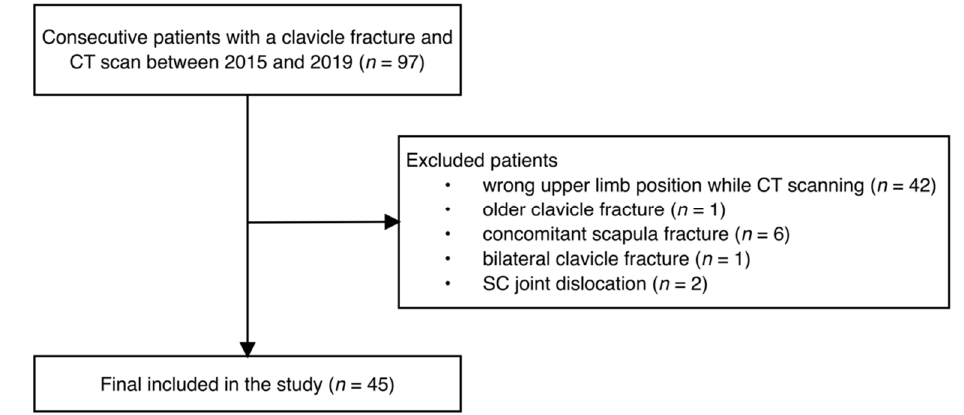
Figure 2. Flow chart showing the definition of the study population.